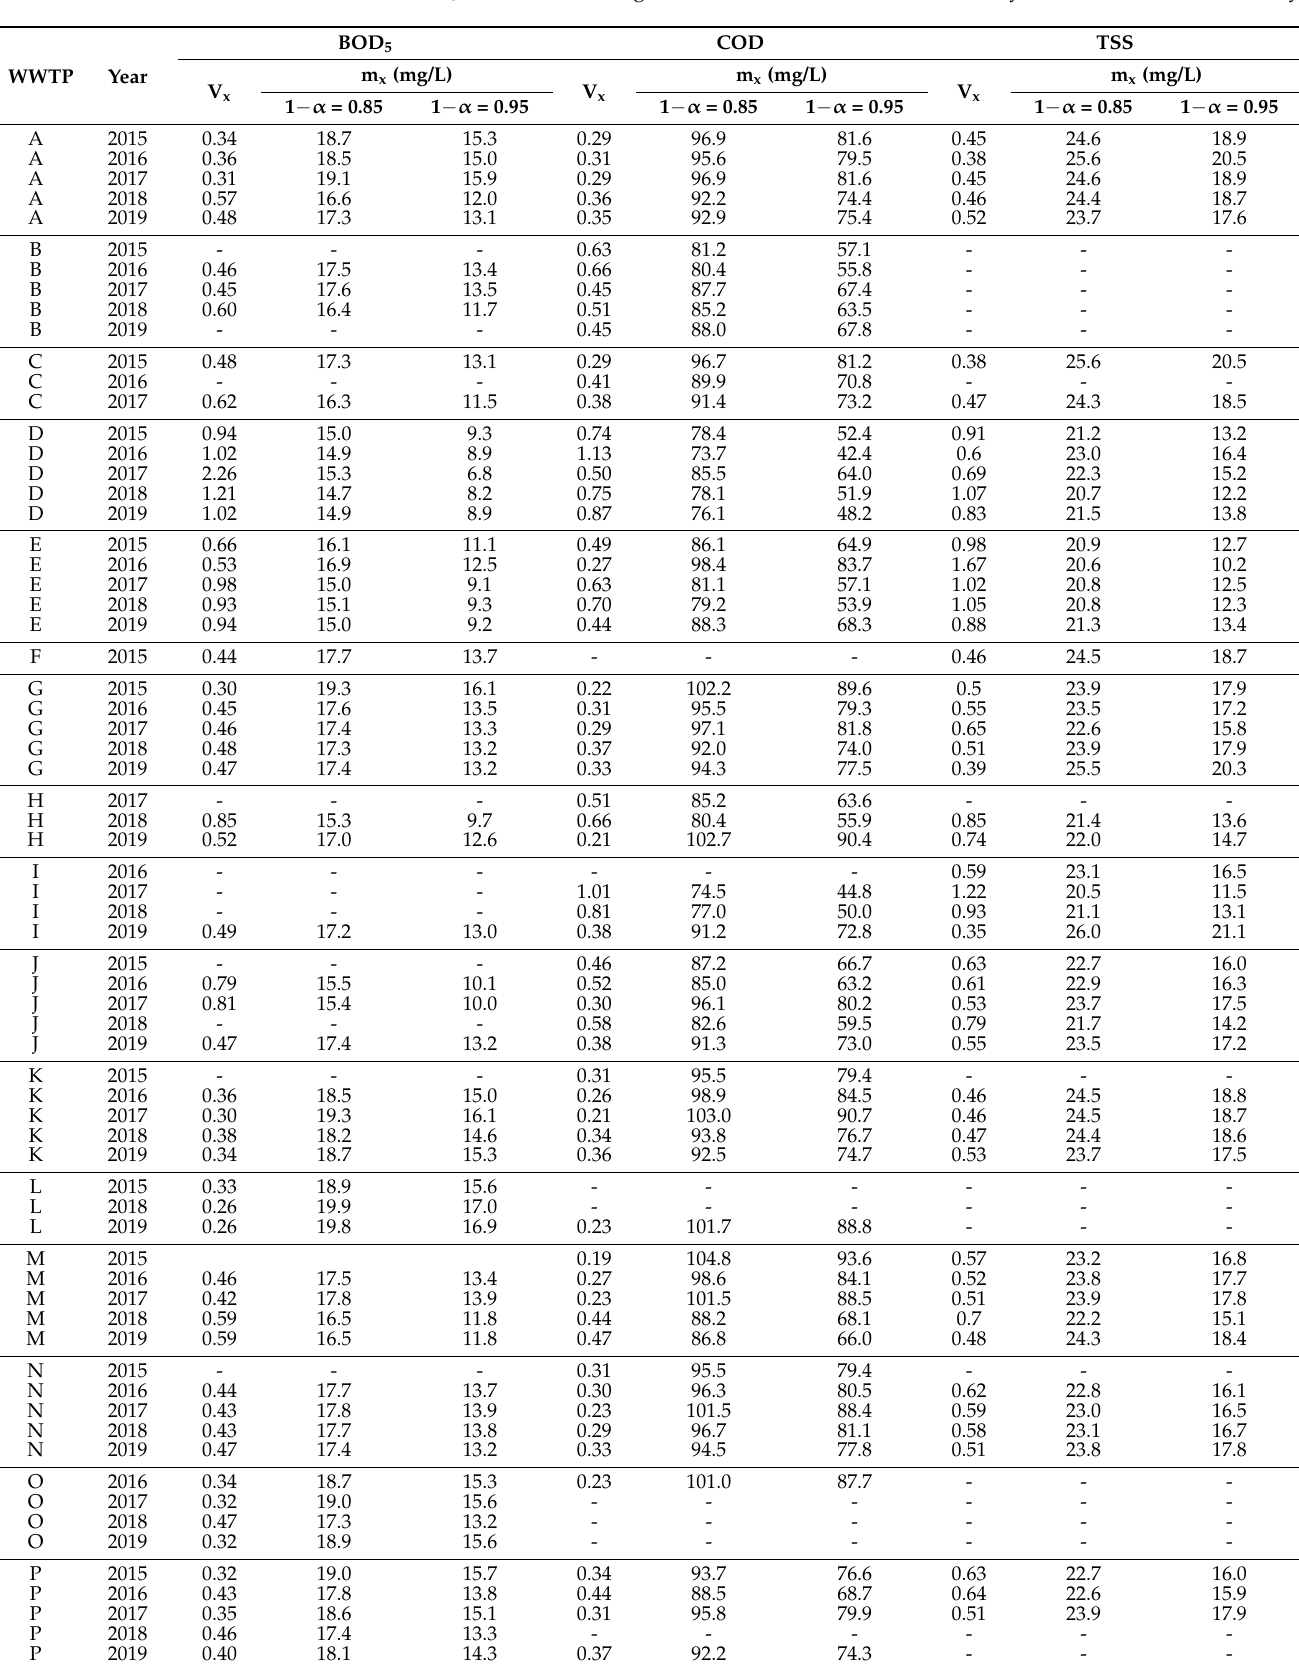
Table 3. BOD 5 , COD, and TSS target mean values for each WWTP in each year, for 0.85 and 0.95